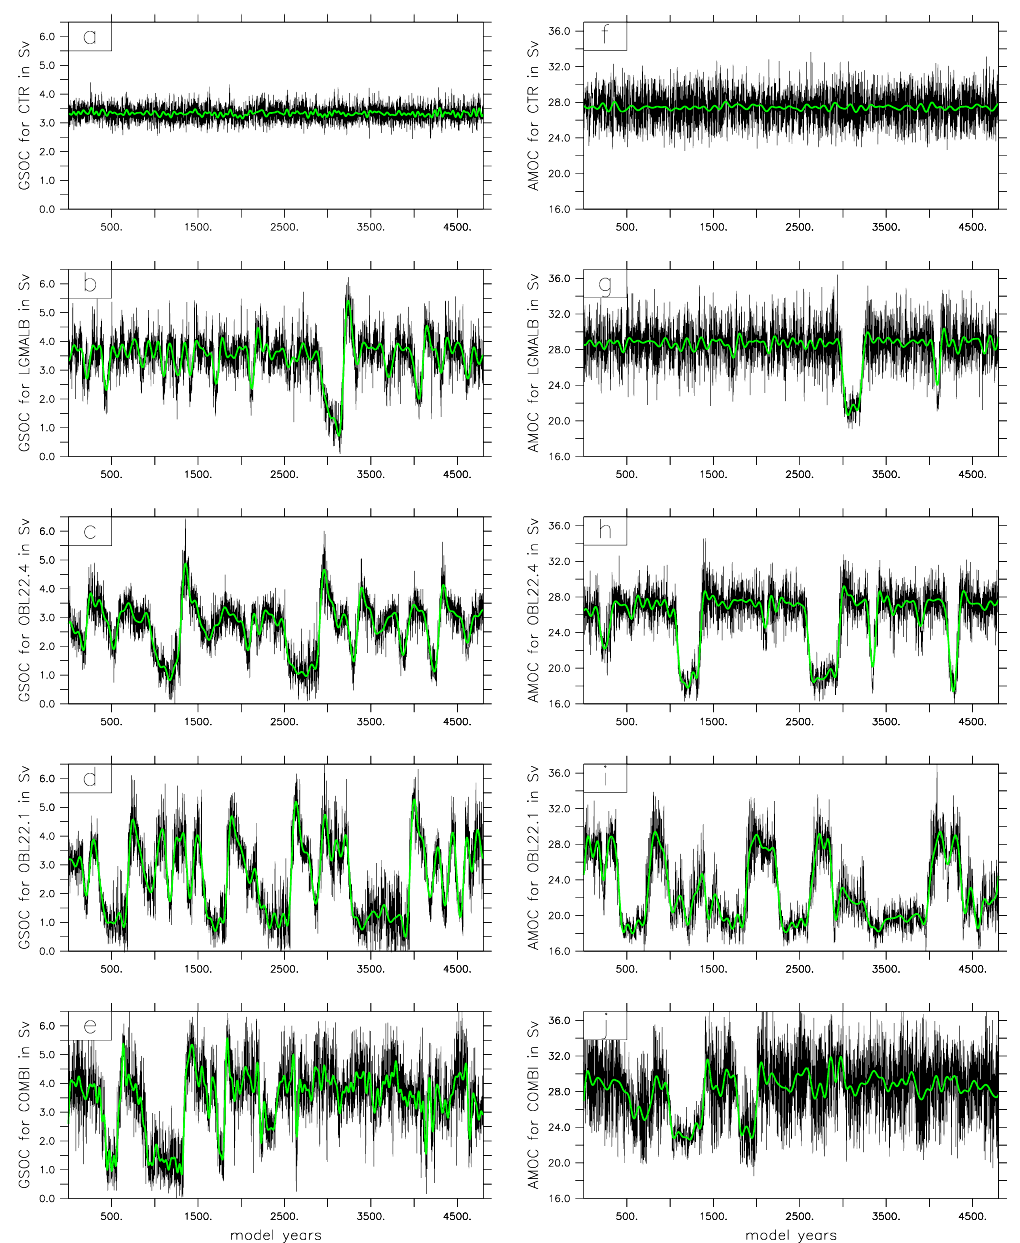
Fig. 2. GIN Sea overturning circulation (GSOC) (a–e) and maximum of Atlantic overturning circulation (AMOC) (f–j) in Sv for indicated model simulations. Please refer to Table 2 for an explanation of the simulations. A low pass filter of 50years was applied for green